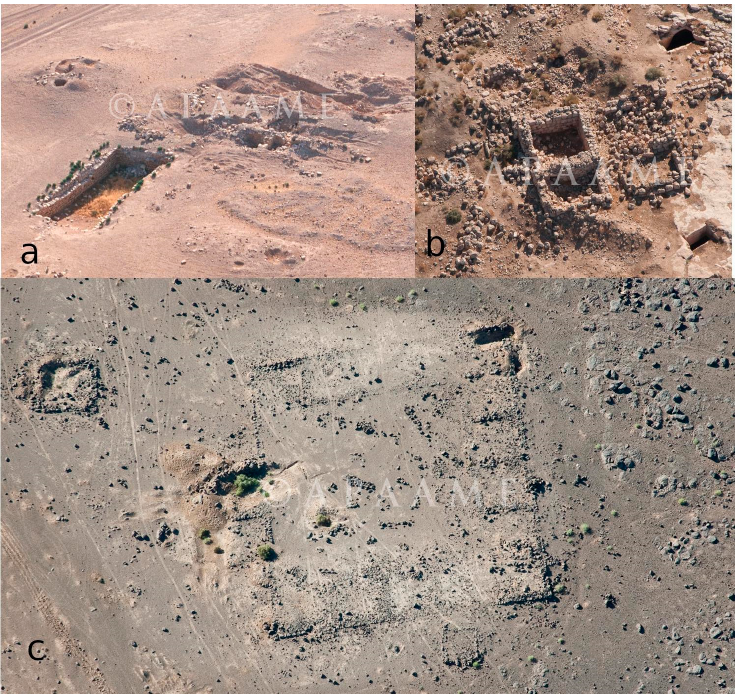
Figure 4. Example of raw ruined structure features (examples are from APAMME; samples 4088792676_8ccc54c75d_h ( a ), 15532537376_7fab380e39_o ( b ), and 5123243570_0933def600_o ( c ).